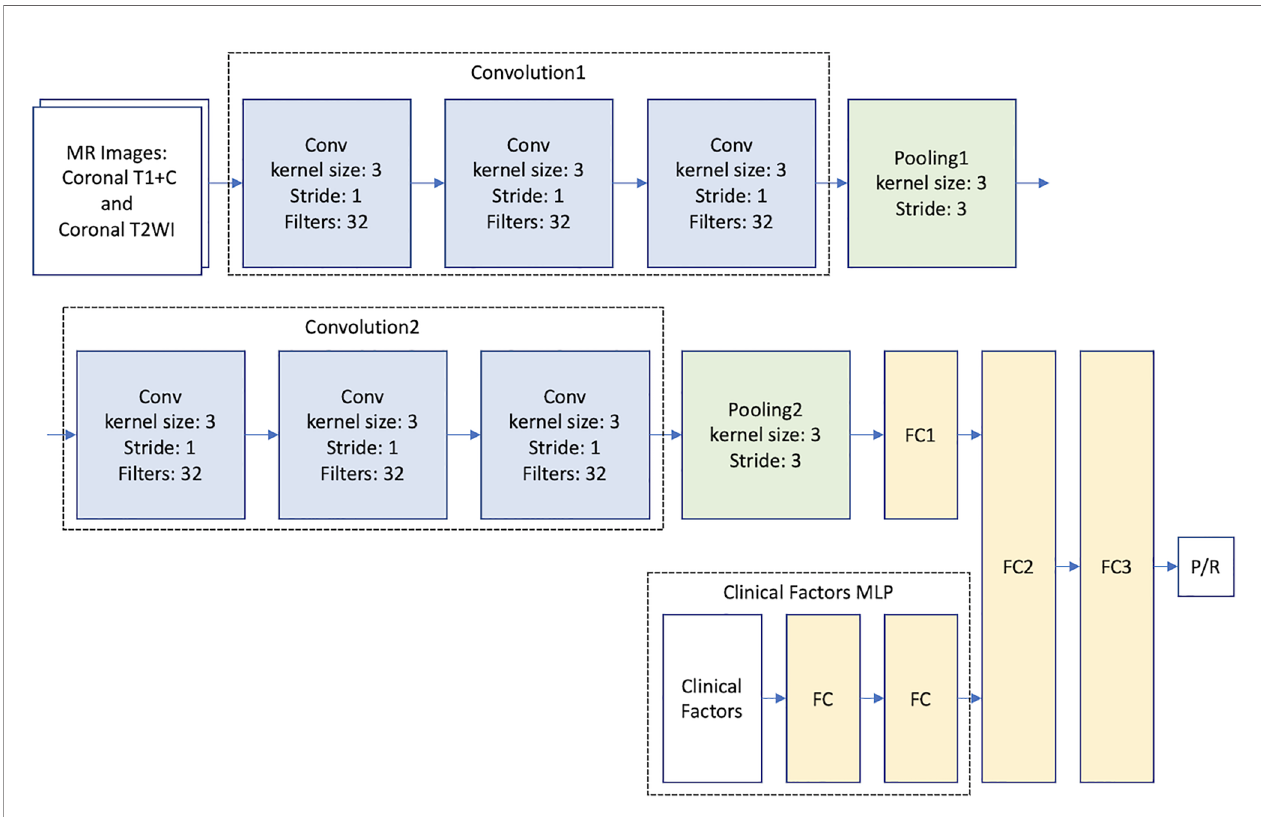
FIGURE 2 | Multimodal CNN_v1-MLP architecture for prediction of progression/recurrence (P/R) in